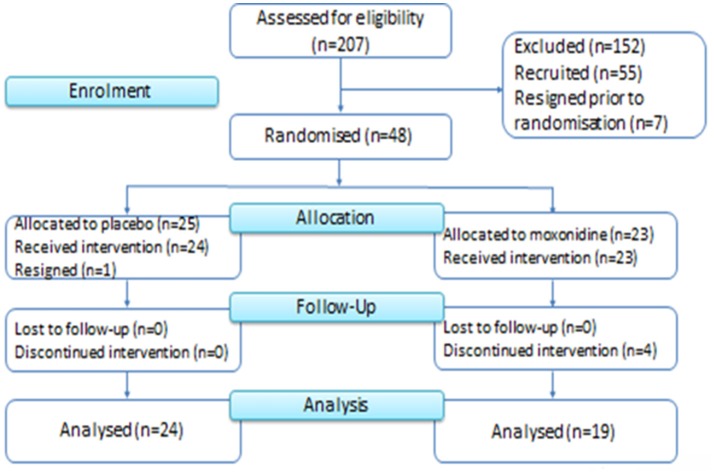
Consort diagram of recruitment and study flow.